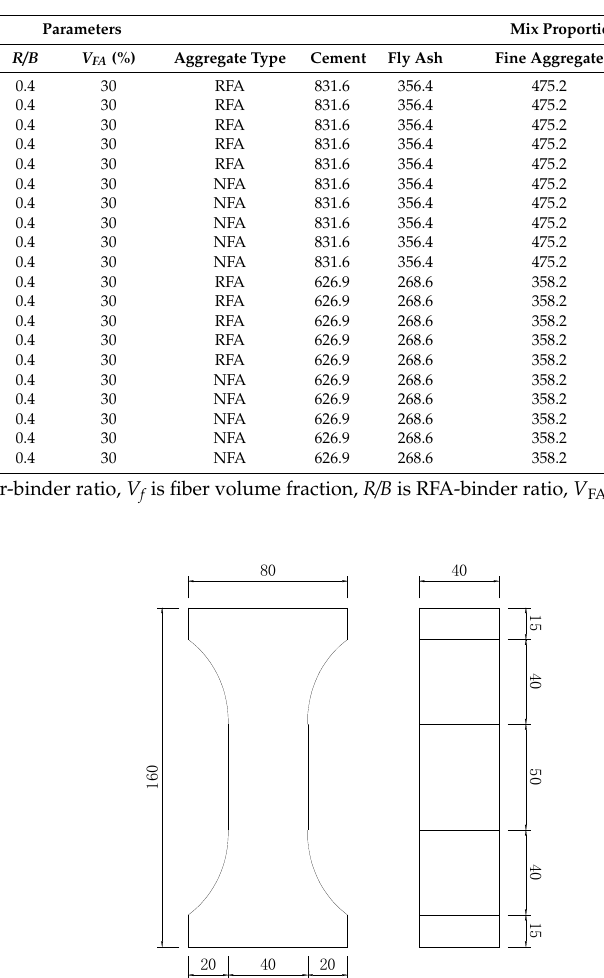
Table 3. Mix proportions of raw materials.